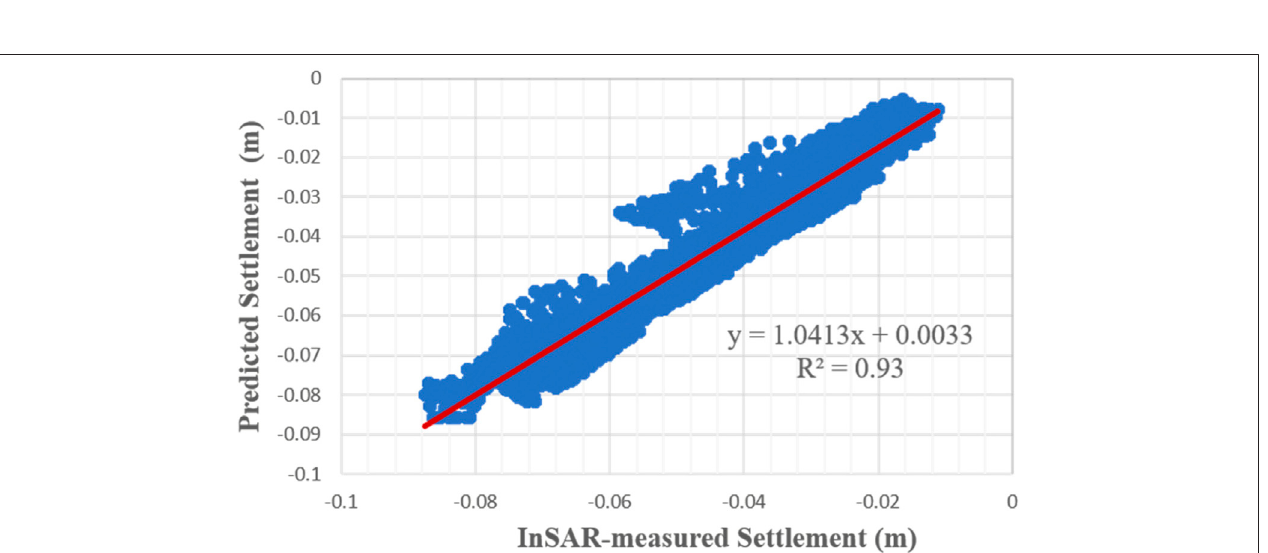
Frontiers in Environmental Science |